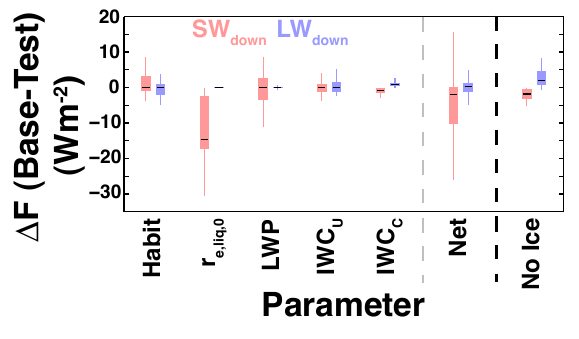
Fig. 5. Distributions of differences between downwelling shortwave (red) and longwave (blue) flux densities derived using base parameters (see text for details), and those derived with alternate values for the parameters shown. IWC U represents the sensitivity of surface flux densities to IWC retrieval uncertainty, while IWC C represents the sensitivity to the coefficient used in the empirical relationship. IWC C is not accounted for in the net calculation shown. The no ice calculation on the far right compares clouds with ice included in radiative transfer calculations, and the same clouds with ice removed. The mean value is indicated by the black line in each distribution, the box indicates the IQR, and the whiskers represent 1.5xIQR beyond the 25th and 75th percentiles. Outliers are not shown, and nightime cases are omitted in the shortwave evaluation.